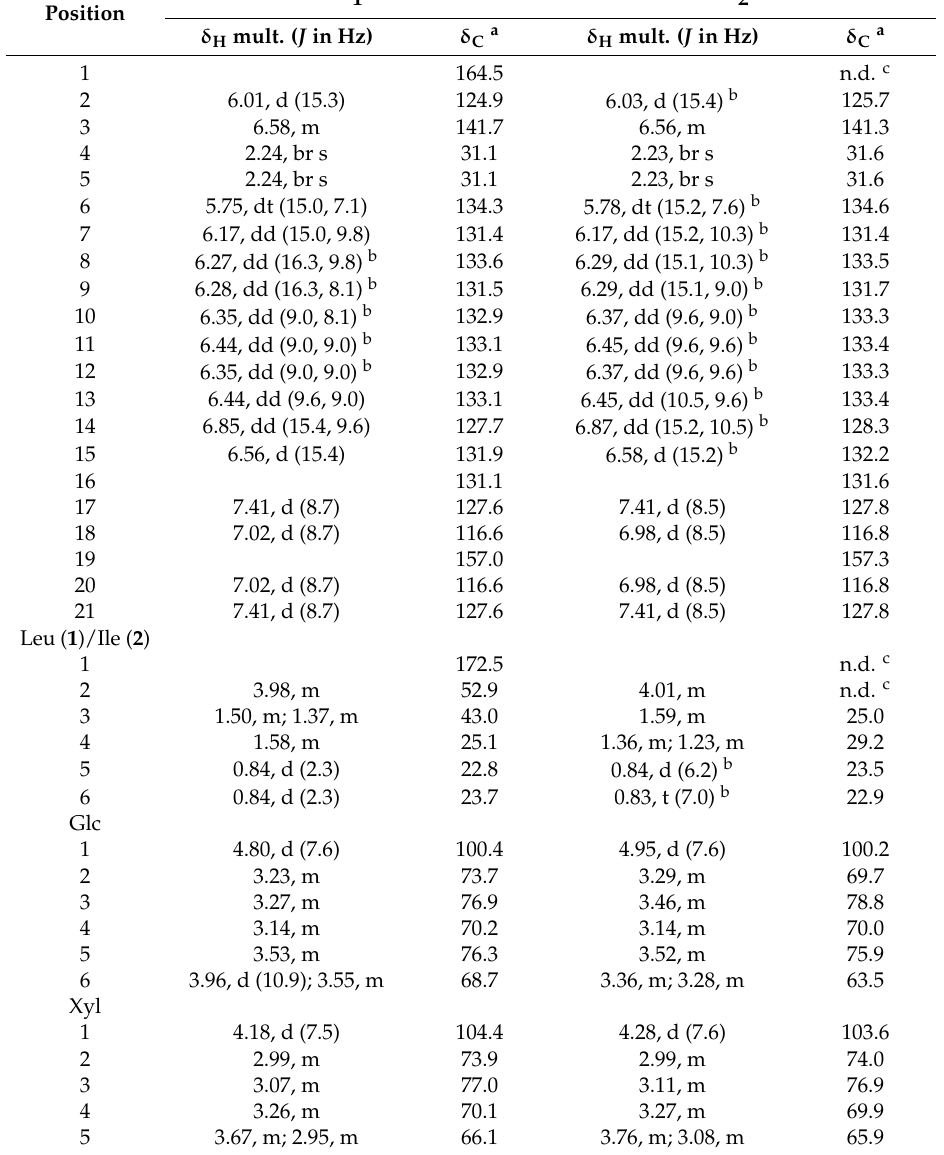
Table 1. The 1 H (850 MHz) and 13 C (212.5 MHz) NMR spectroscopic data ( δ in ppm) of compounds 1 and 2 (DMSO- d 6